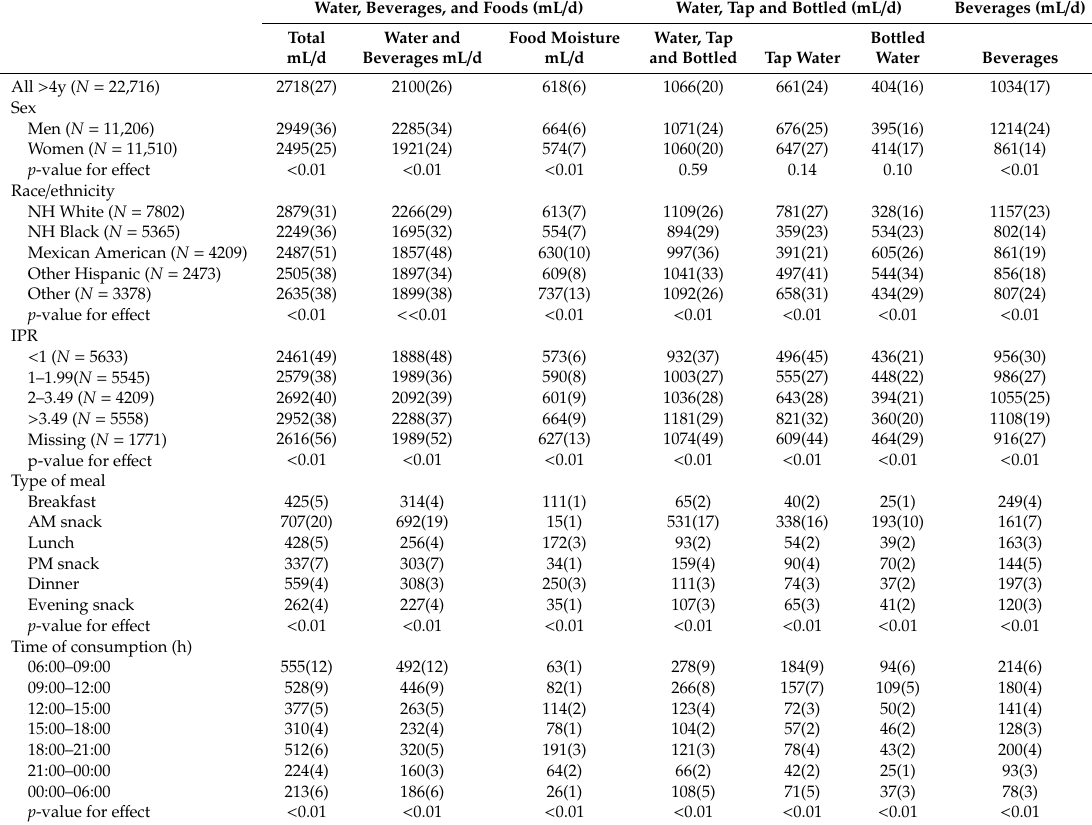
Table 1. Water intakes (mL / d) from beverages and foods (mean, standard error) by individual characteristics and time. Data are pooled for 2011–2016 NHANES cycles. Data are means and SEMs. Water, Beverages, and Foods (mL /